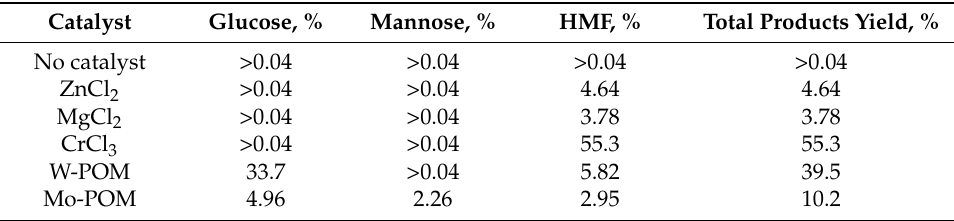
Table 1. Glucose, mannose and 5-hydroxymethylfurfural (HMF) contents in cellulose samples degraded in [BMIM]Cl using ZnCl 2 , MgCl 2 , CrCl 3 , tungsten (W-POM) and molybdenum (Mo-POM) oxide-based polyoxometalates (POMs) as catalysts. Catalyst loading was 10 wt % from cellulose and cellulose loading was 10 wt